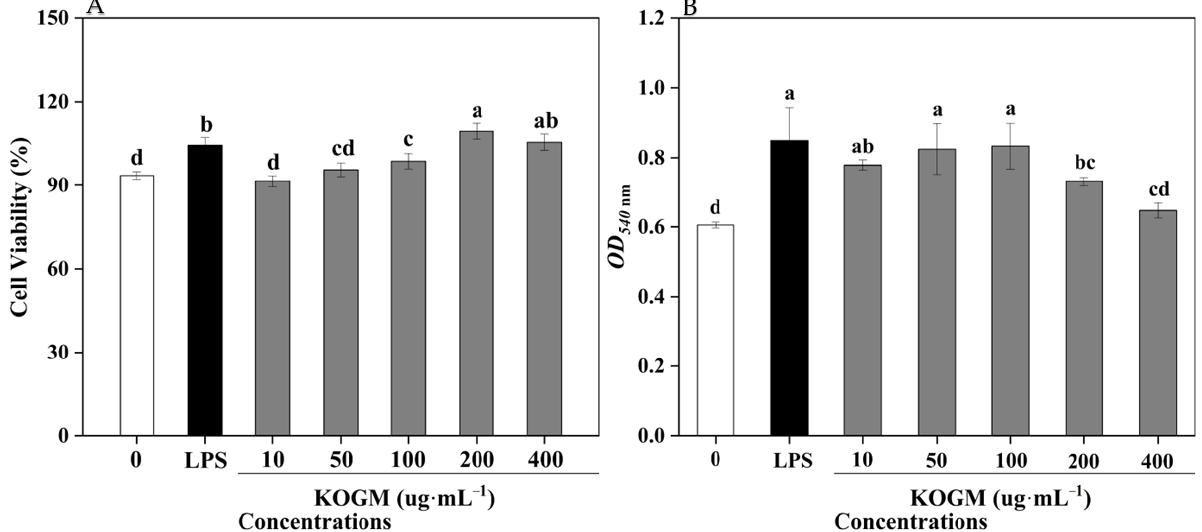
Figure 7. Effects of W. cibaria F1 mannanase on cell viability ( A ) and macrophages phagocytosis ( B ) of RAW264.7 macrophages in vitro . Different letters in superscript donate significant difference ( p < 0.05).